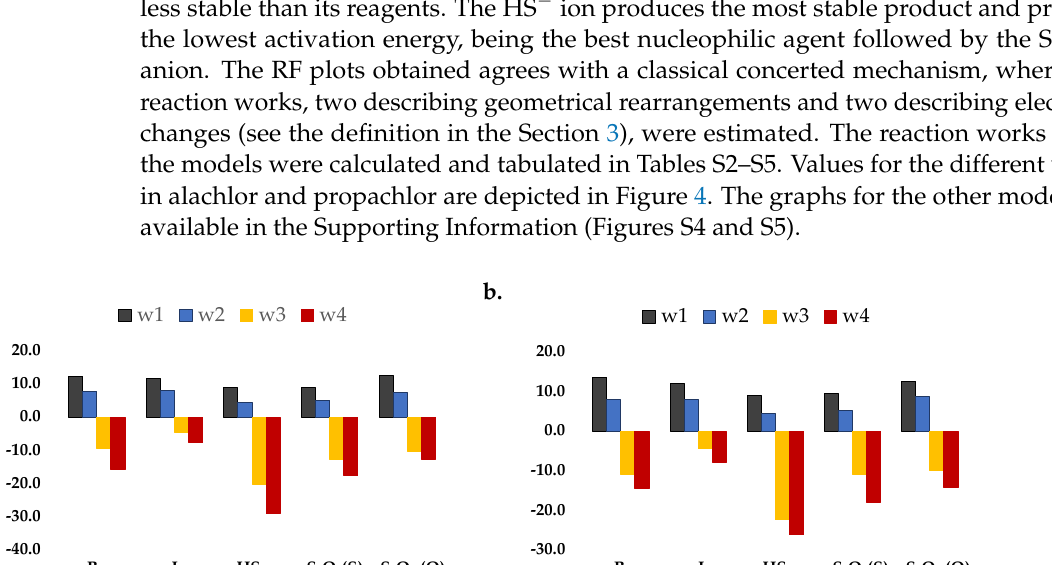
Figure 3. IRC and RF plots for the nucleophilic substitution of alachlor ( a , b ) and propachlor ( c , d ).